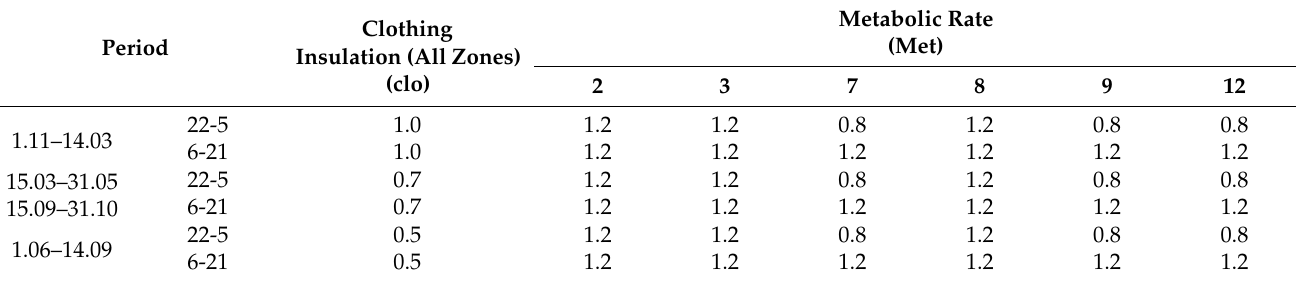
Table 6. Parameters used in the calculation of PPD index in each